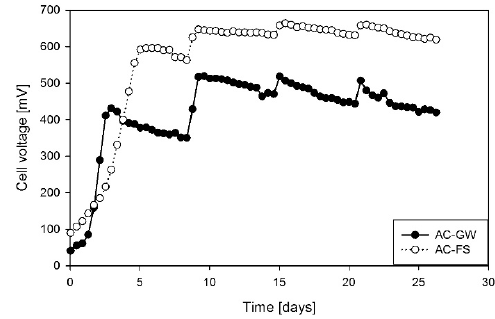
Figure 2. Electricity generation of MFCs operated with palm kernel shell activated carbon (AC) as electrode material testing FS and GW as inocula.